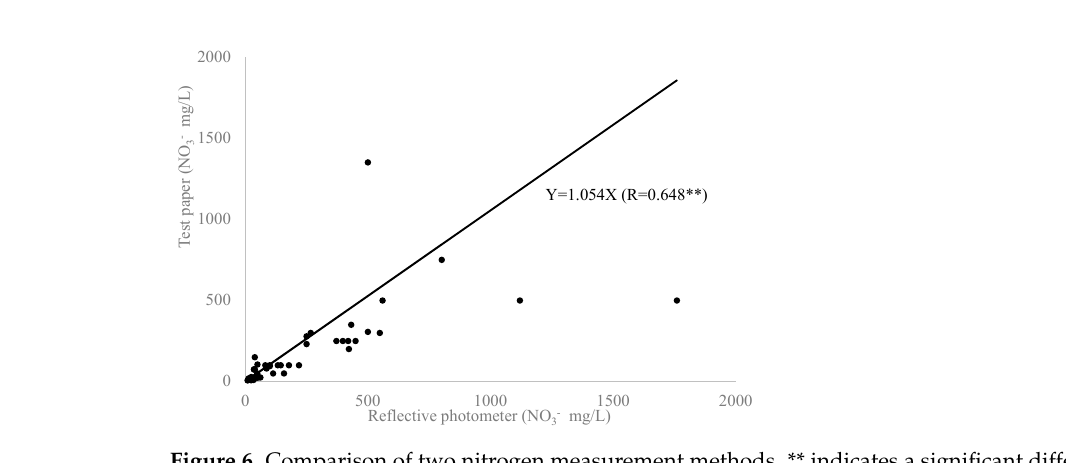
Figure 6. Comparison of two nitrogen measurement methods. ** indicates a significant difference at the 1% level ( n = 45, p = 0.294).